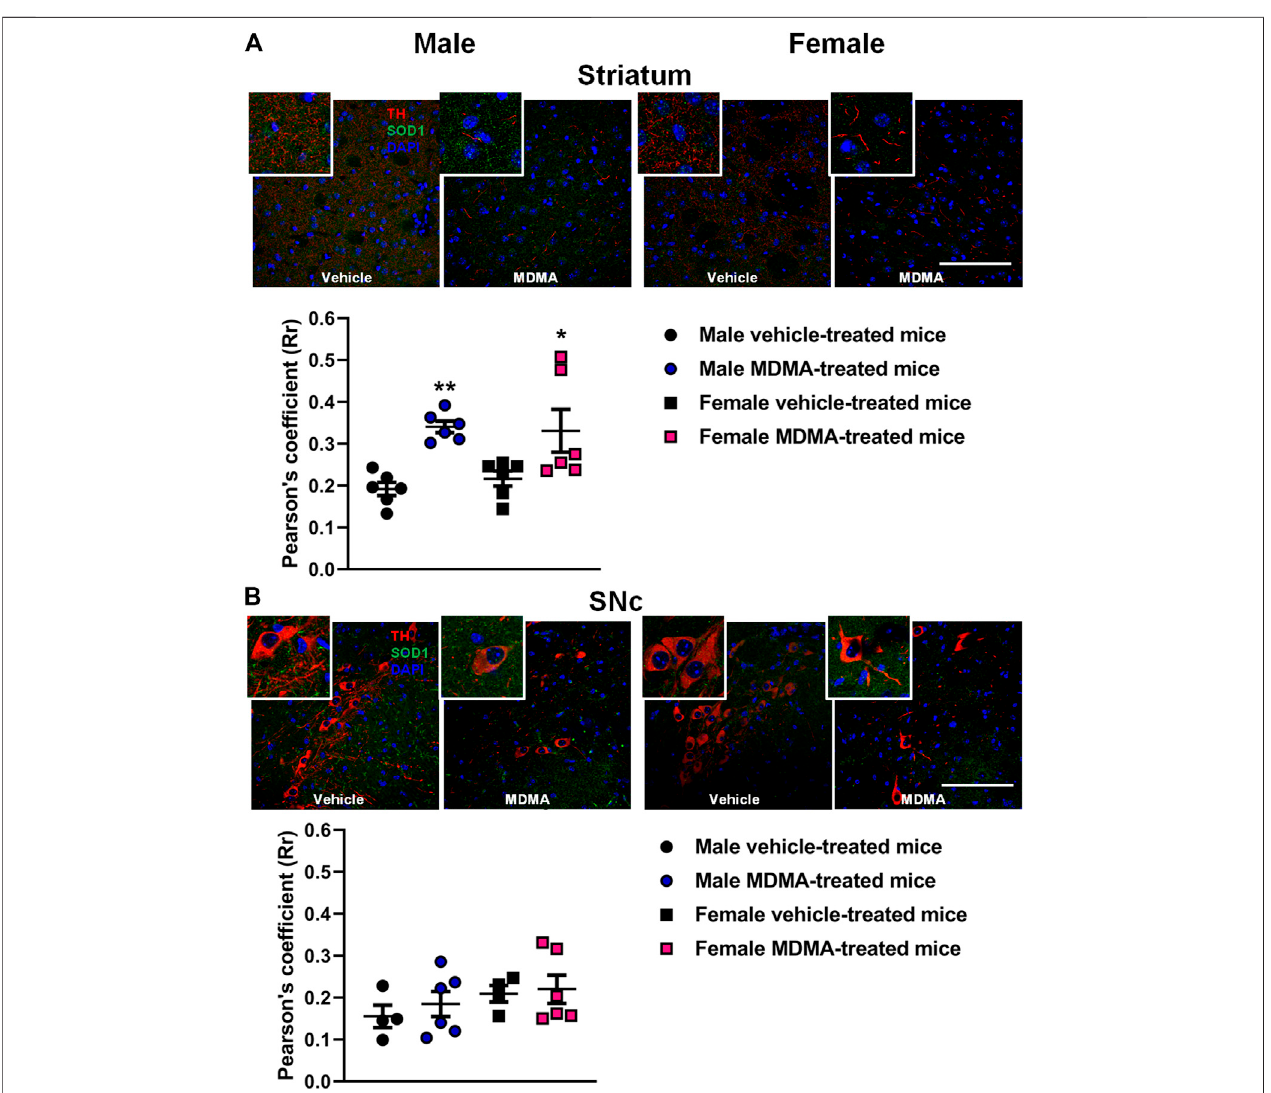
FIGURE 1 | Effectsof treatment with MDMA on the co-localization ofsuperoxide dismutase 1(SOD1) with fi bers and neurons positive to tyrosine hydroxylase (TH) in the striatum (A) and substantia nigra pars compacta (SNc) (B) . Adult male and female mice were treated with either MDMA (4 × 20 mg/kg, i. p. 2 h apart) or vehicle (salinesolution,i.p.).N (cid:2) 5 – 6micepergroup.Valuesarereportedasmean ± S.E.M.* p < 0.05,** p < 0.01comparedwiththerespectivegroupofvehicle-treatedmiceby Newman-Keuls post-hoc test. Scale bar: 50